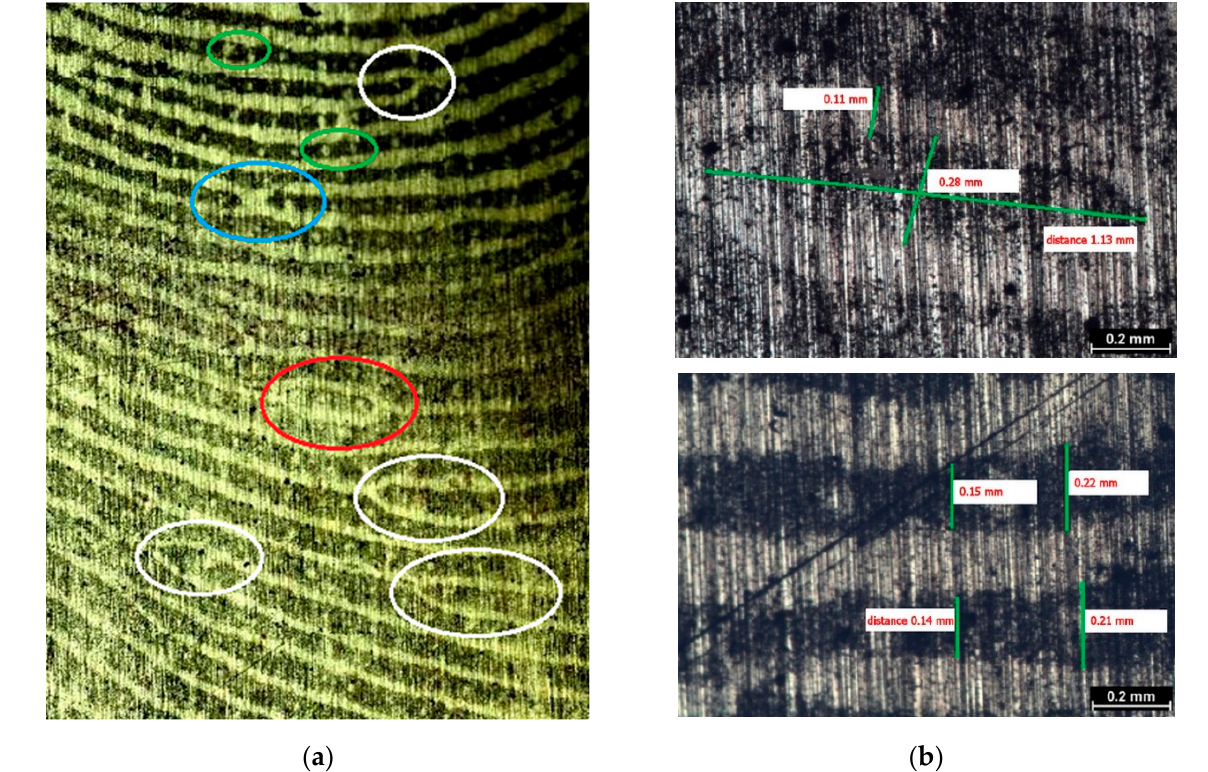
Figure 5. Image of details of the visualized fingerprint on the brass plate ( a ) obtained with a Leica microscope. Marked